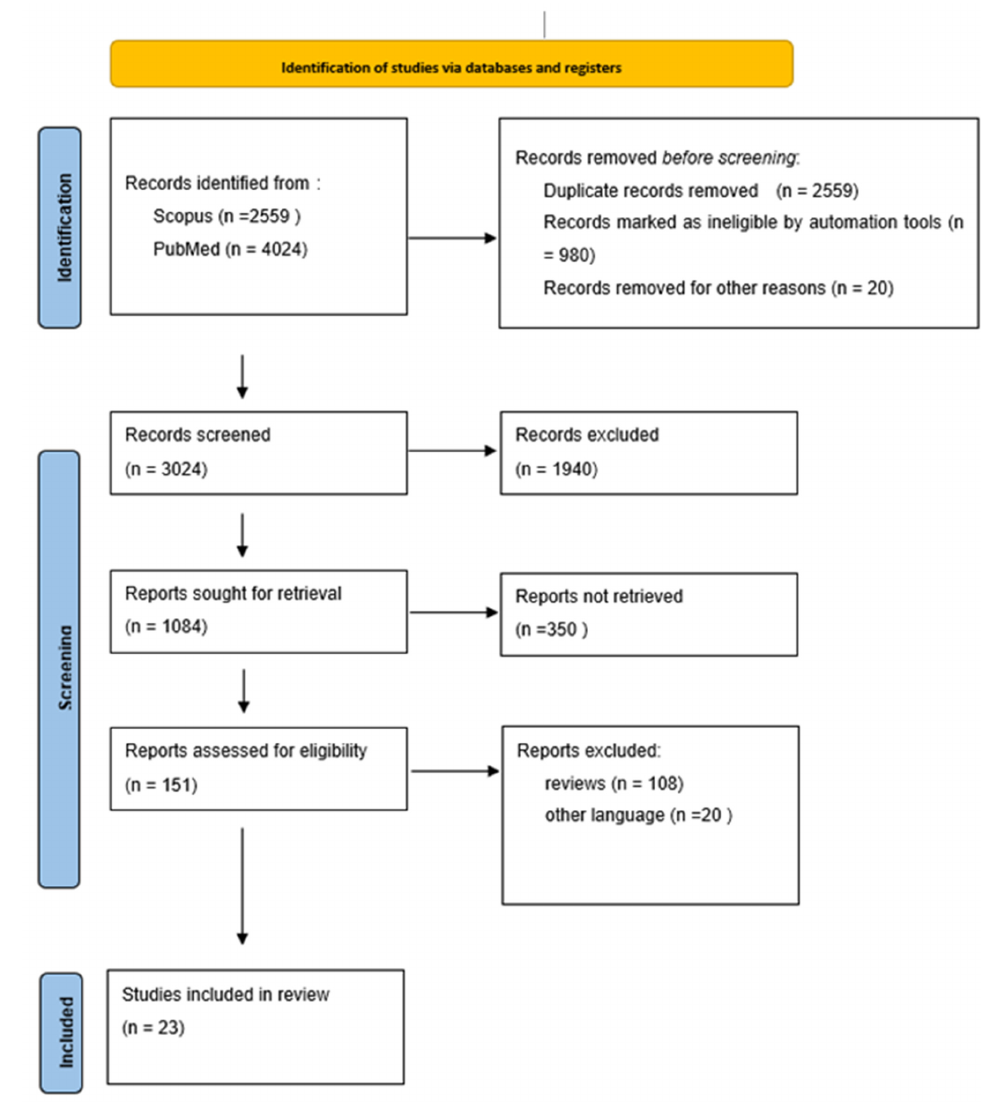
Figure 1. PRISMA Flow chart.